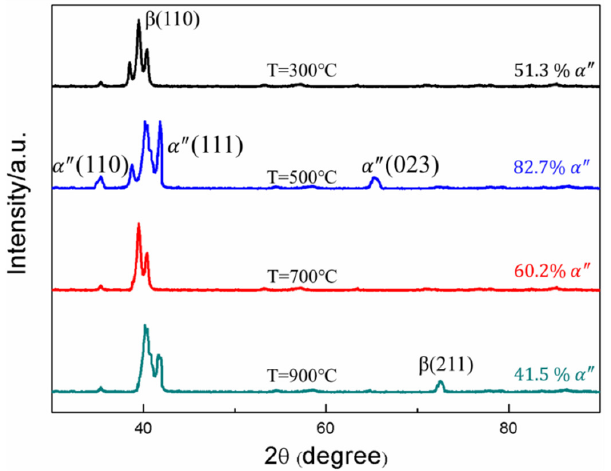
Figure 7. Torsional region X-ray diffraction patterns of TB6 at different temperatures.